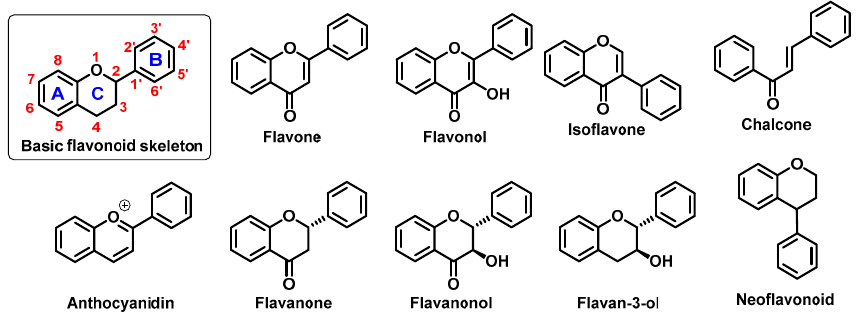
Figure 1. Basic flavonoid structure showing rings A, B and C and the numbering, flavonoids and chalcone chemical structures. Specific flavonoids form can be represent by anthocyanidins and anthocyanins (their gly- cosylated form), derivates of 2-phenylbenzopyrylium cation [4]. Unlike other flavonoids, they are intensive pigments, and are responsible for the red, blue and purple color of many plant parts. The most common anthocyanidins are cyanidin, delphinidin, peonidin,